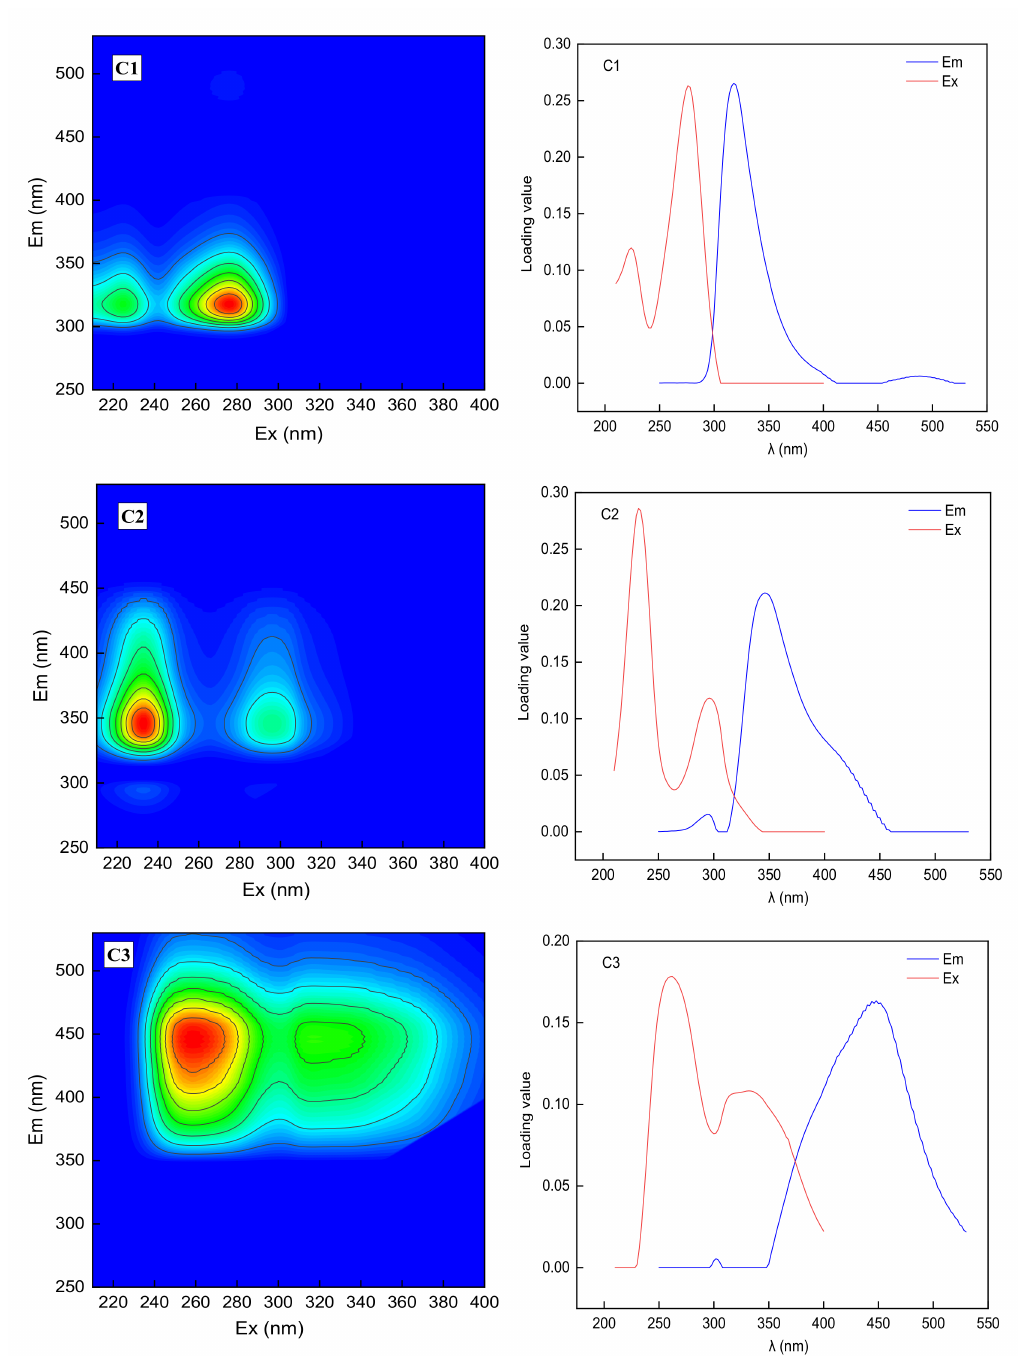
Figure 3. Fluorescence spectra of components of CDOM identified by the parallel factor analysis (PARAFAC) model in the overlying water of Lake